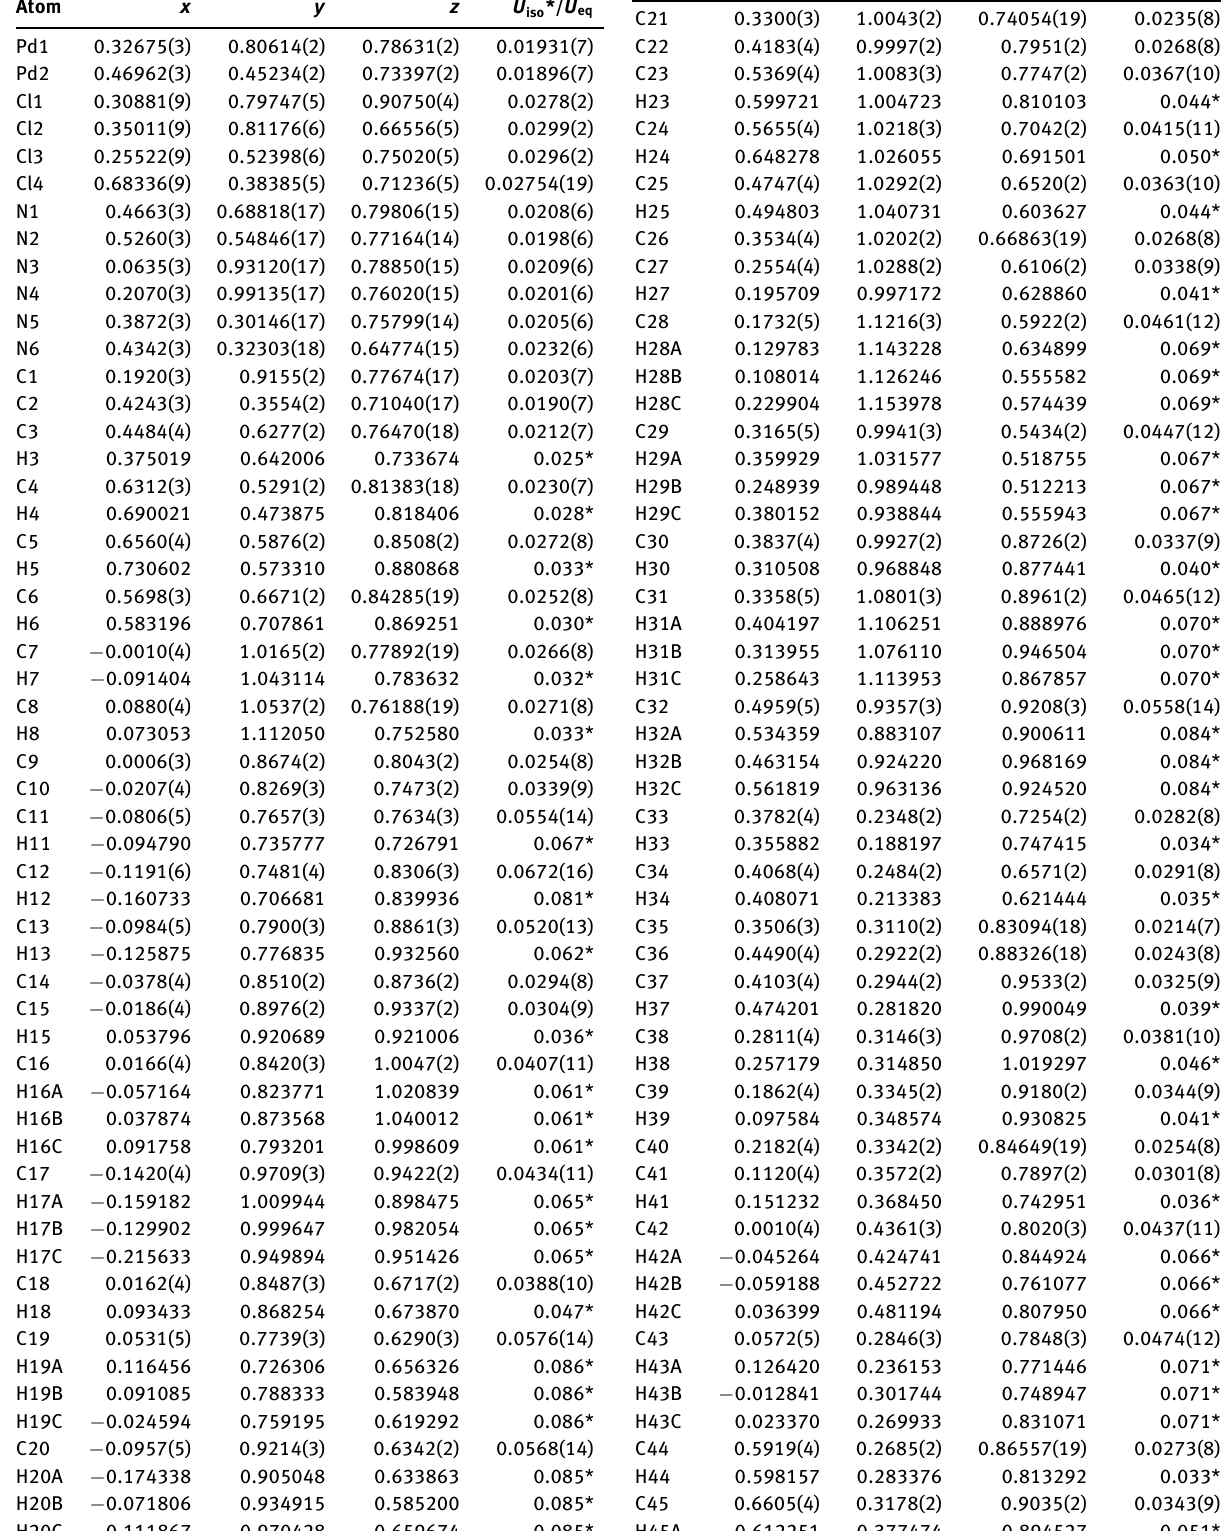
Table 2: Fractional atomic coordinates and isotropic or equivalent isotropic displacement parameters (Å 2